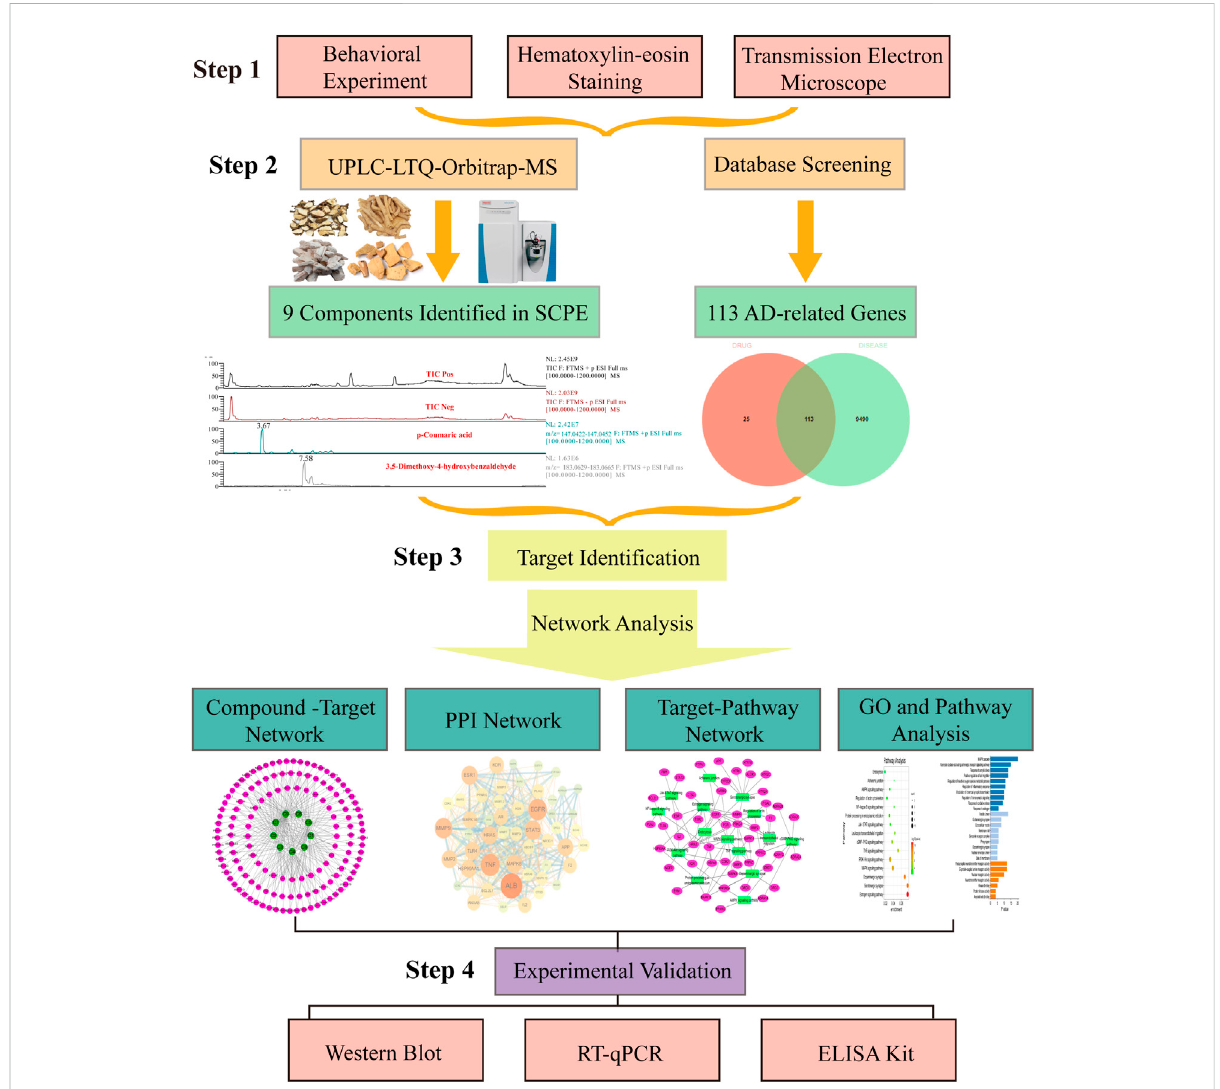
FIGURE 1 Flow of experimental research of SCPE in the treatment of Alzheimer ’ s disease. Step-by-step graphical representation of the experimental work fl ow.The initial step in this process is to demonstrate the effectiveness of SCPE. Followed by a second step, which is the analysis of active ingredients of SCPE by UPLC-LTQ-Orbitrap-MS. Based on the ingredients found in previou step, the third step is combined with network pharmacology to fi nd the potential anti-AD mechanism of SCPE. Step 4 Use molecular biology techniques verify Experiment. The fi nal step in this experiment is to experimentally verify the anti-AD effect of